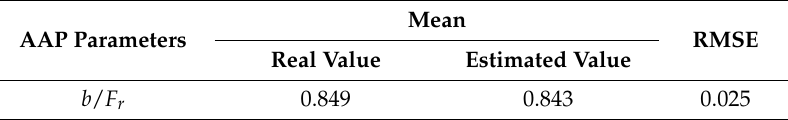
Table 2. The performance analysis of the proposed